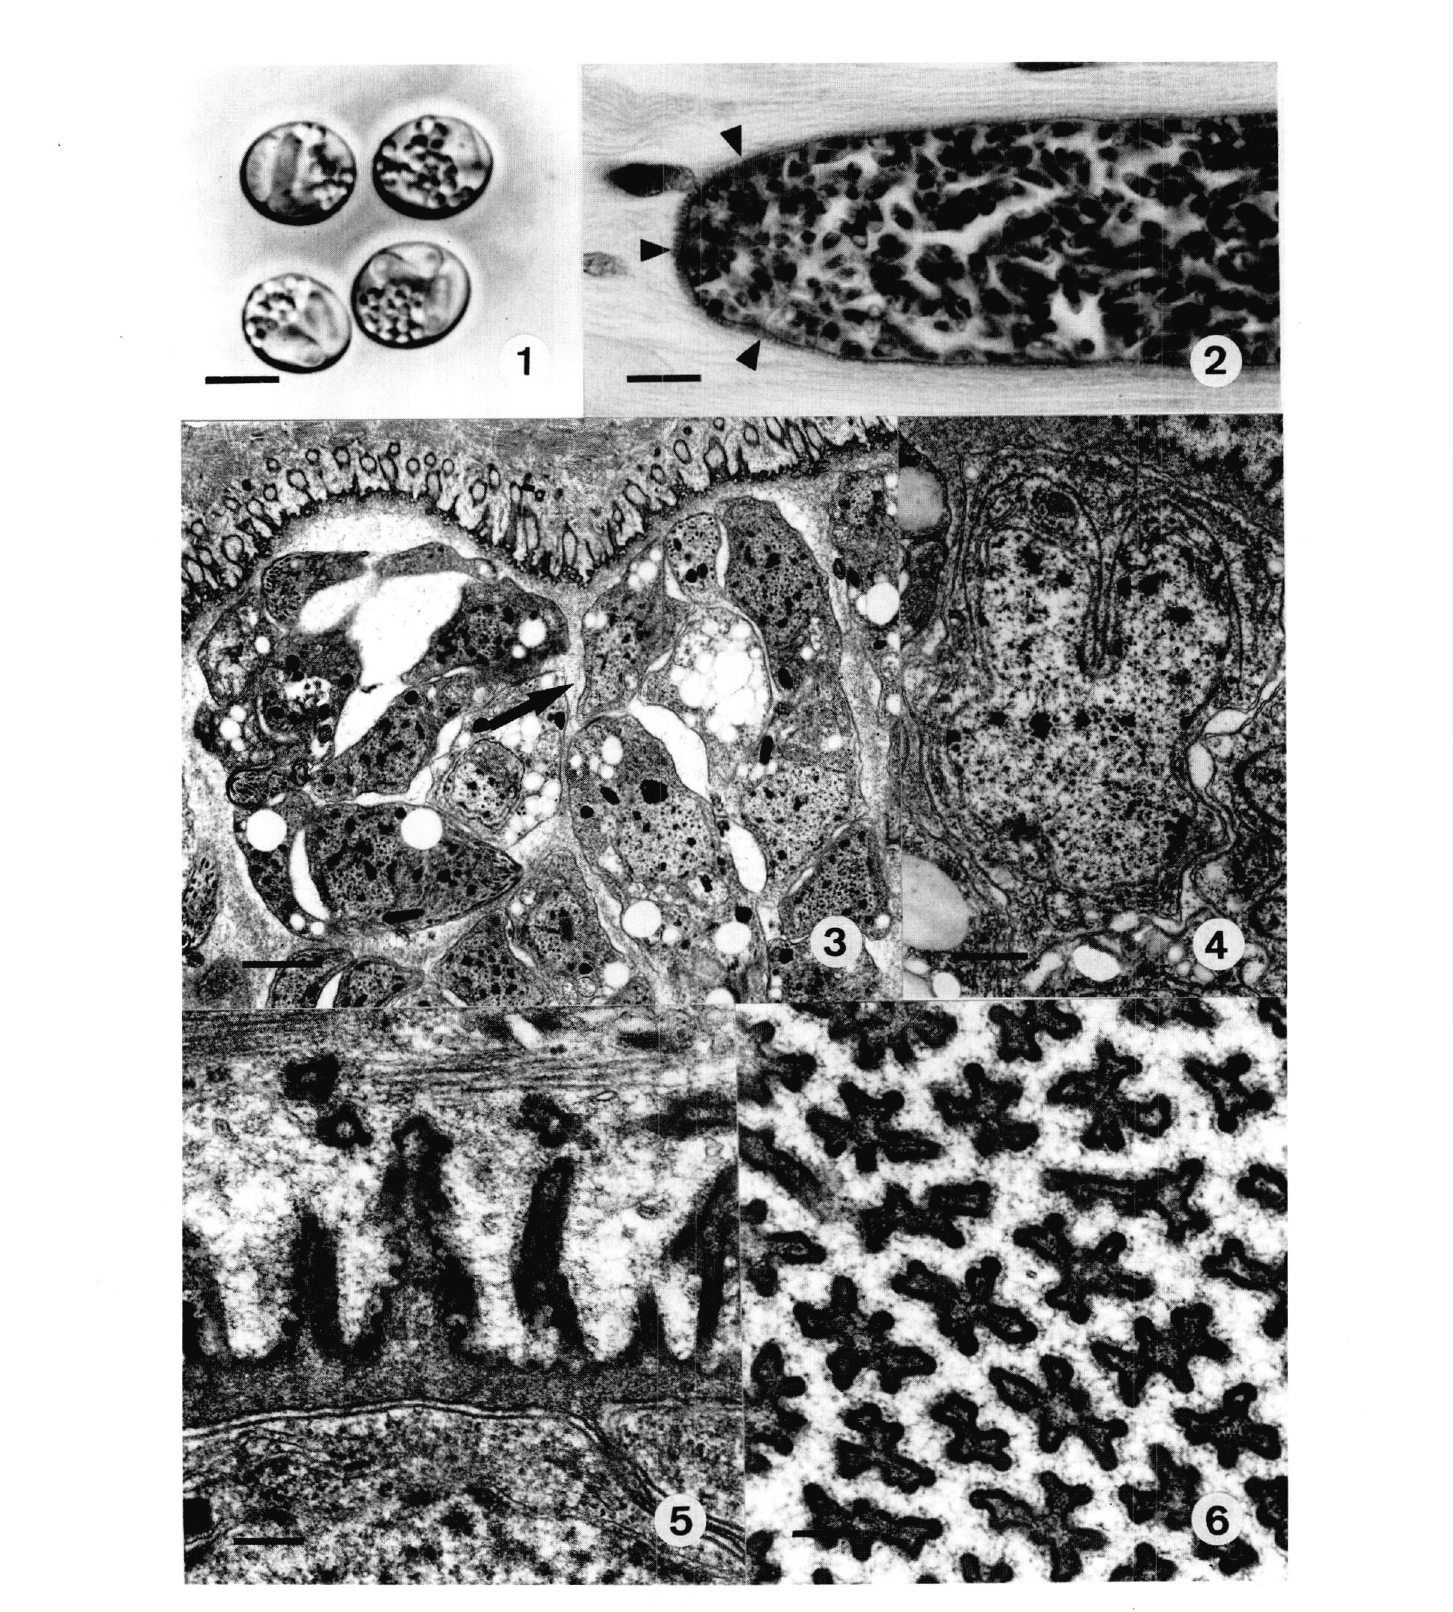
Figs 1-6. - Basic morphological features of Sarcocystis stenodactylicolubris sp. n. Fig. 1. Sporocysts isolated from faeces of C. najadum, scale bar = 5 µm. Fig. 2. Histological section of the tail musculature of S. grandiceps with sarcocyst, note barely visible villar protrusions (arrowheads). Fig. 3- Ultrastructure of sarcocyst of Sarcocystis stenodactylicolubris showing several cystozoites, septa and protrusions. Fig. 4. Cystozoites dividing by the endodyogony. Fig. 5. Spine-like villar protrusions of the primary cyst wall, scale bar = 200 nm. Fig. 6. Cross- section through the zone of protrusions showing their lobular character.